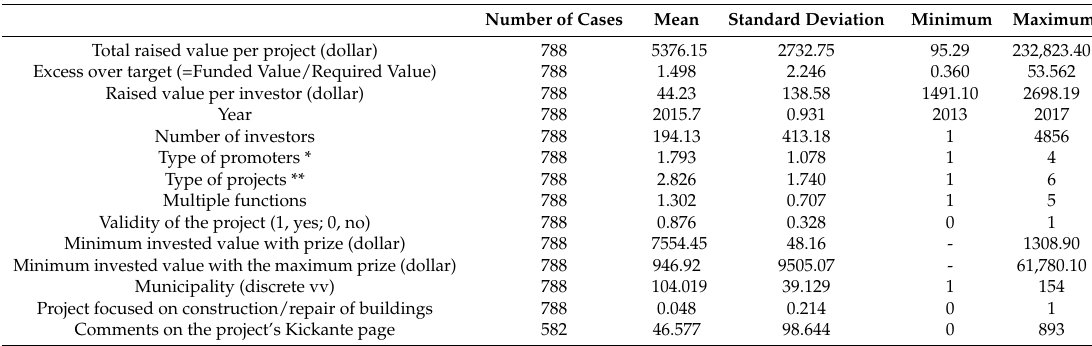
Table 2. Descriptive